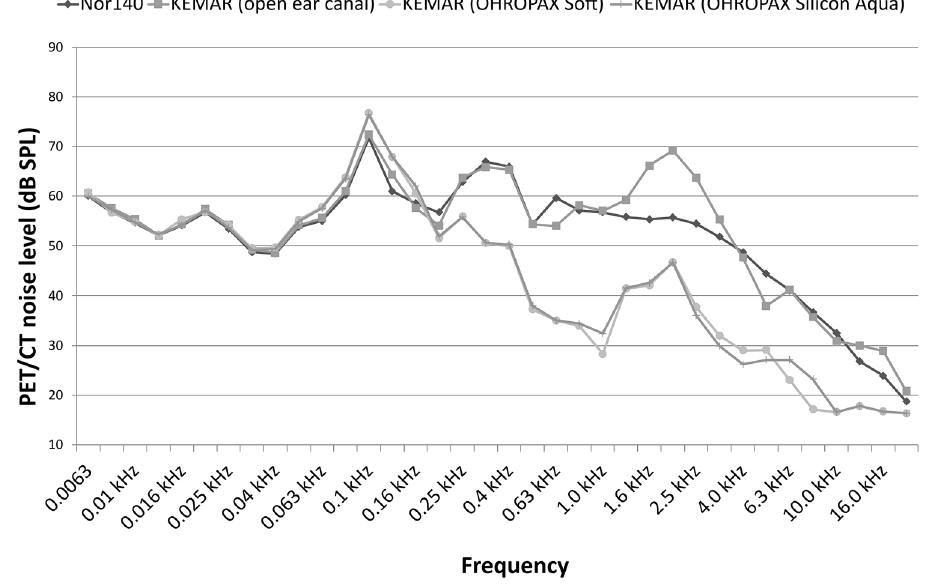
Figure 3. Amplitude spectrum of PET background noise recorded from the Vereos